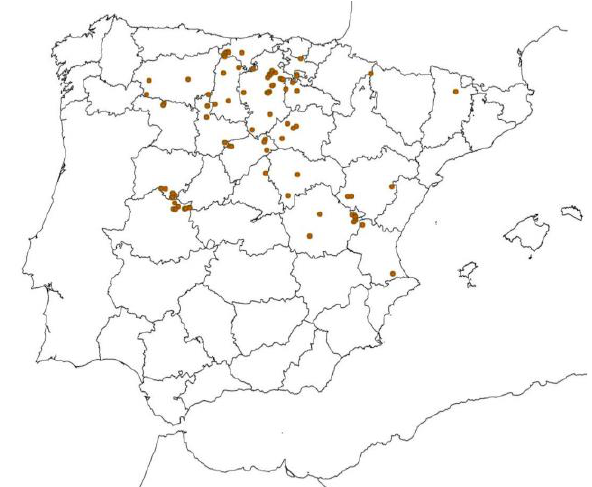
Figure 2. Geographical distribution of the 83 sites where earth and wood mixed walls have been located.